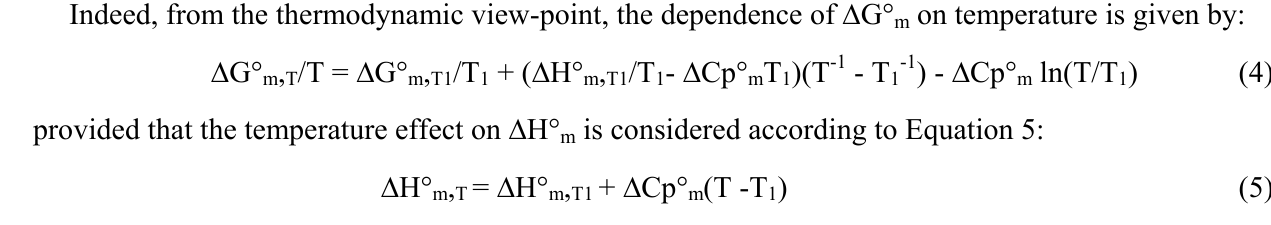
Figure 2. Dependence of the CMC on temperature for the aqueous solutions of sodium dodecylsulfate ( ● ) and cetylpyridinium chloride ( ○ ). Data are from Ref. [15].